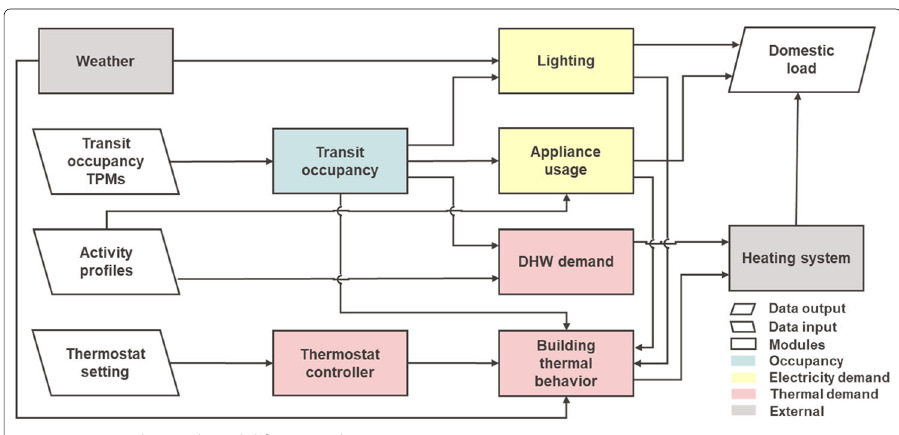
Fig. 2 Energy demand model